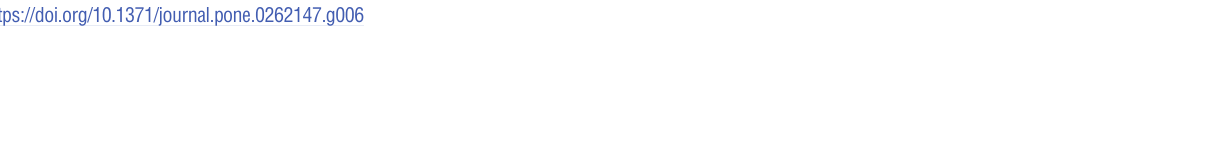
Fig 6. UpSet plot diagram of upregulated and downregulated CCT genes during/after vernalization compared with pre-vernalization. A: Upregulated genes; B: Downregulated genes. The leaf samples were harvested the same as those in Fig 5. Transcriptome sequencing was conducted to obtain the gene expression data, which was expressed as